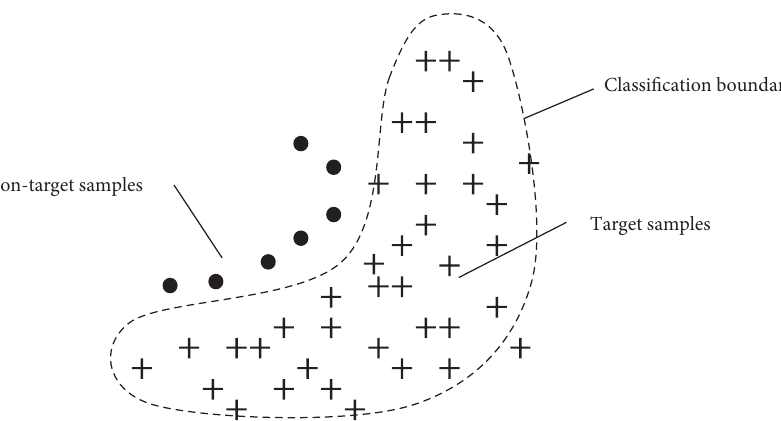
Figure 1: Schematic diagram of single classification of support vector data description.